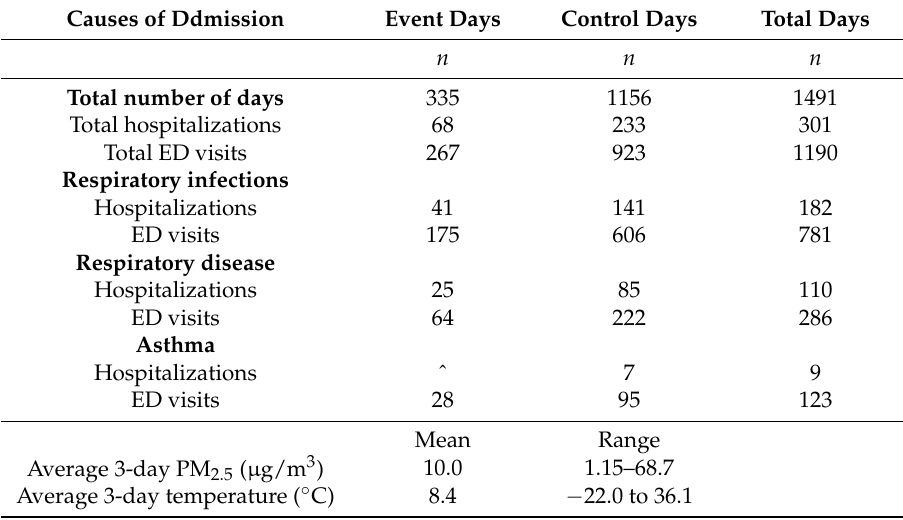
Table 1. Event and control days, number of hospital and emergency department (ED) event days, and mean PM 2.5 and temperature included in the case-crossover